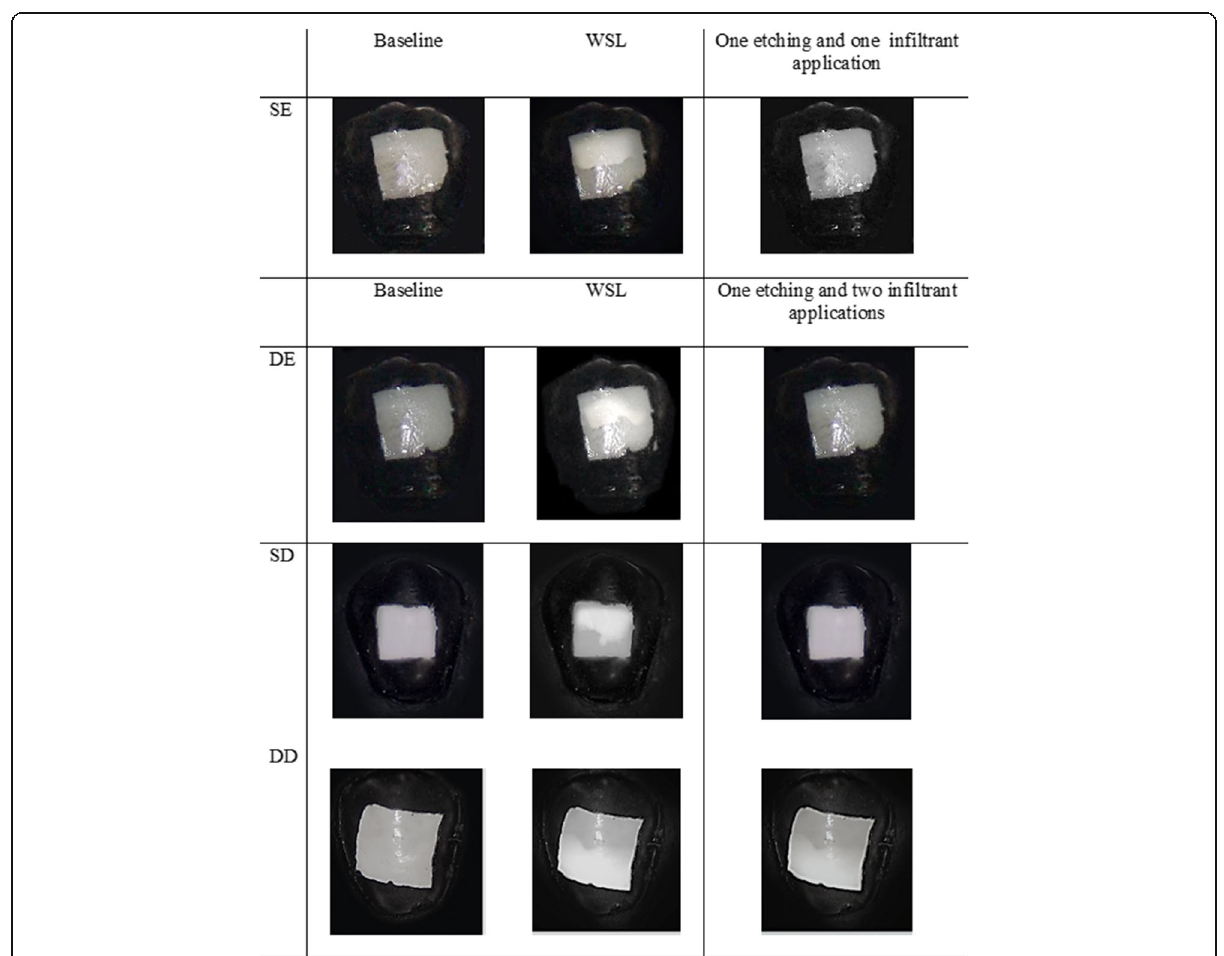
Fig. 6 The best resin infiltration protocols in the different depths of WSLs. SE shallow enamel, DE deep enamel, SD shallow dentine, DD deep